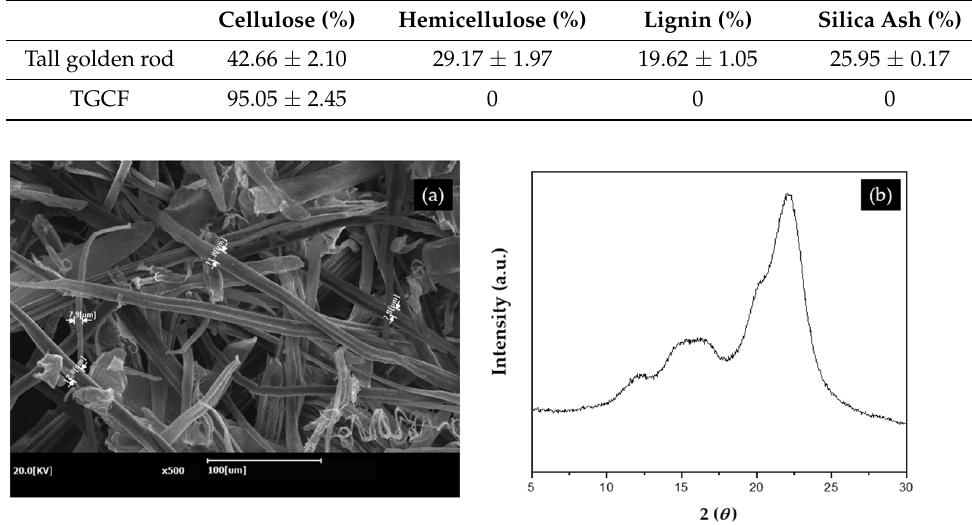
Figure 9. Tall goldenrod cellulose fibers: ( a ) Scanning electron micrograph; ( b ) X-ray diffraction profile.